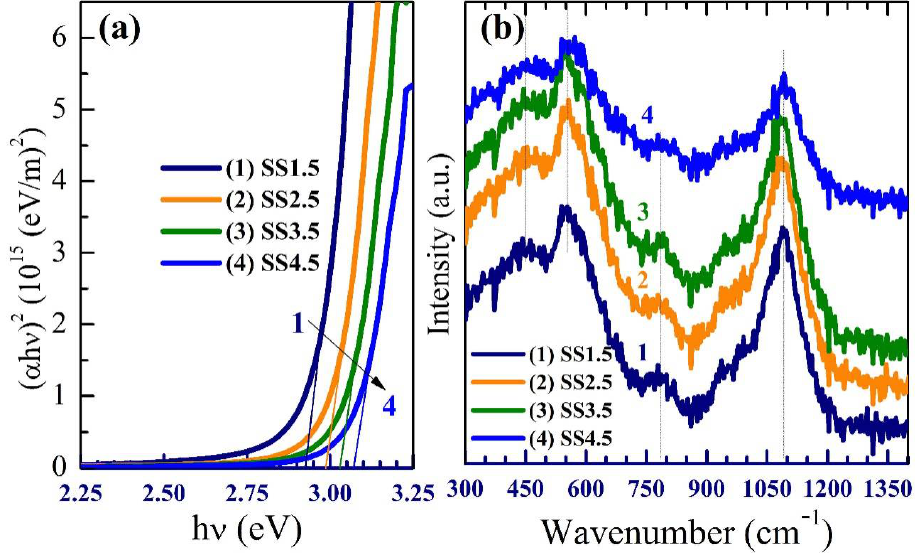
Figure 3. Tauc’s plots for E g determination ( a ), and the Micr-Raman spectra ( b ) of IrOx films spin casted at different SS.